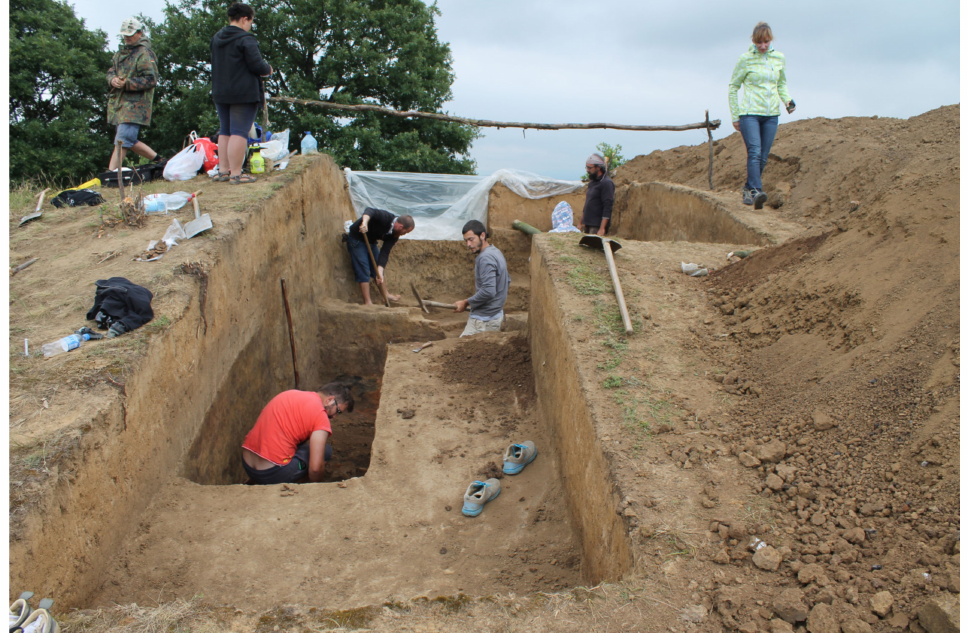
Figure 4. Excavation progress picture (Dragos